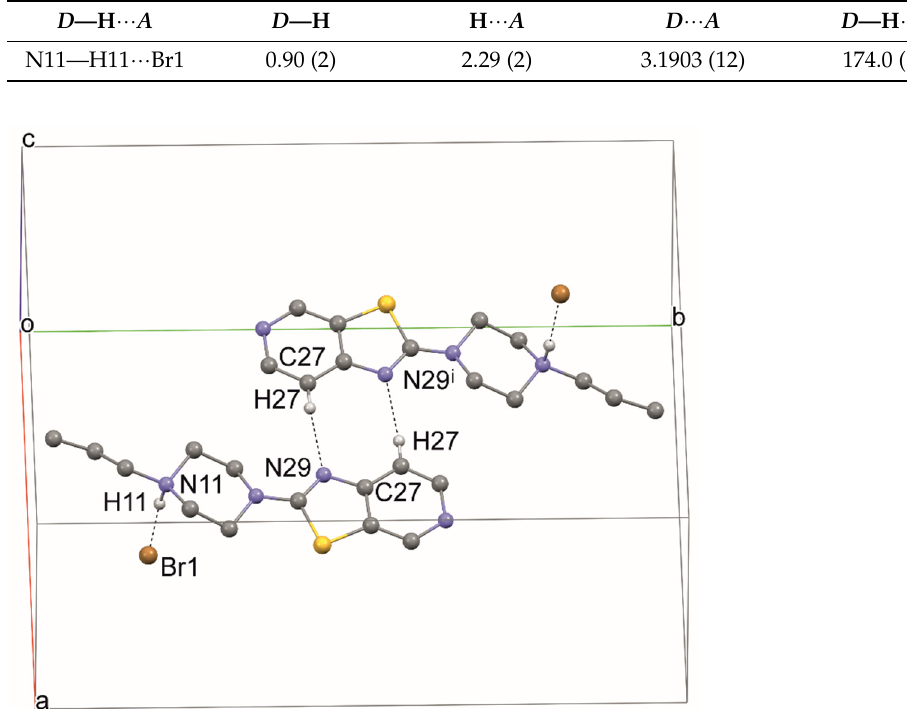
Table 4. Strong hydrogen-bond geometry (Å, º) for 3 . Symmetry codes: (i) − x +1, − y +1, − z +2.